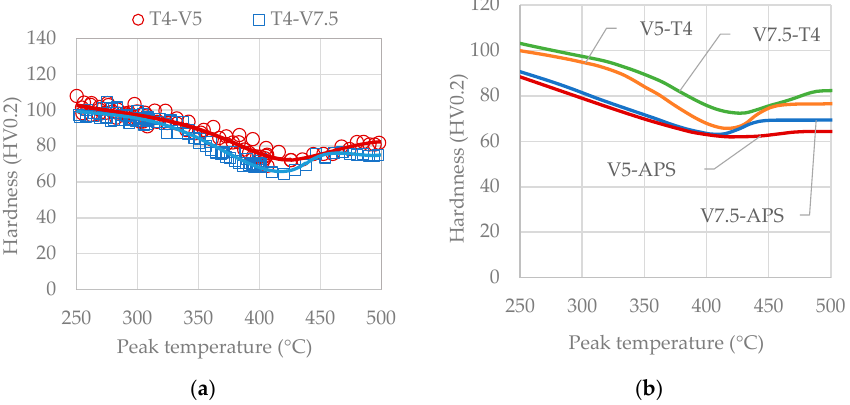
Figure 23. ( a ) Hardness trends as function of peak temperature obtained at treatment speeds of 5 mm/s and 7.5 mm/s in T4 state; ( b ) Comparison of hardness trends as a function of peak temperature between APS and T4 state.